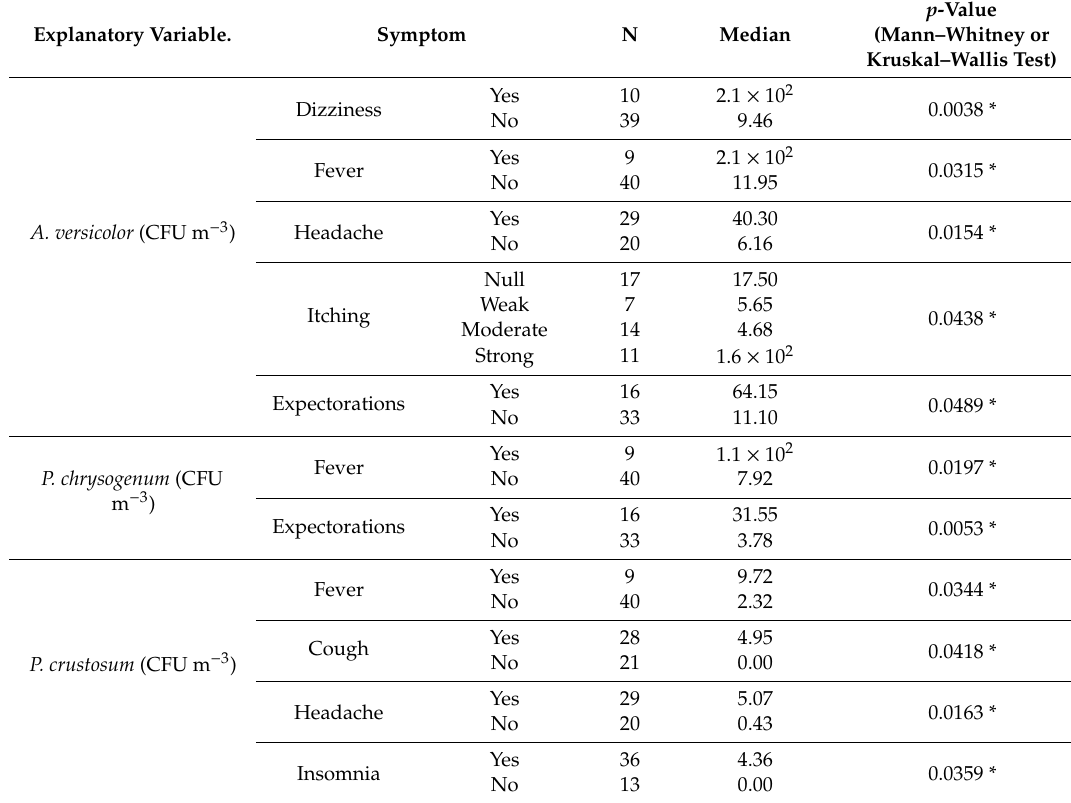
Table 6. Explanatory variables of the symptoms mentioned by inhabitants. Explanatory